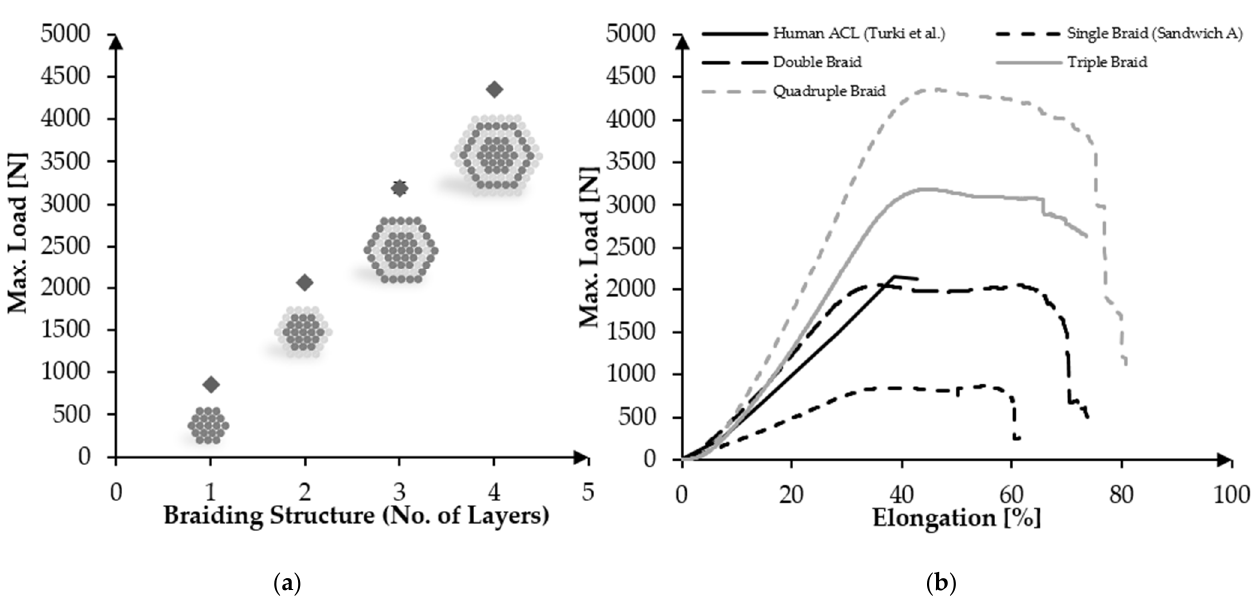
Figure 9. Upscaling of multilayer PCL braids ( n = 3). ( a ) Almost linear relation of the number of layers and max. load ( b ) Force-Elongation curves of the different braids in relation to human ACL based on Turki et al. [68].